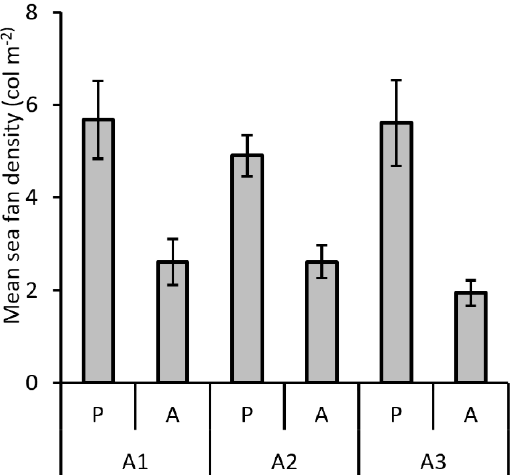
Figure 5. ( a , b ) Specimens of Astrospartus mediterraneus acrophilic on the sea fans Eunicella verrucosa , ( c , d ) Paramuricea clavata, ( e ) E. cavolini (arrows) and ( f ) the sponge Sarcotragus foetidus . Scale bars: 10 cm.